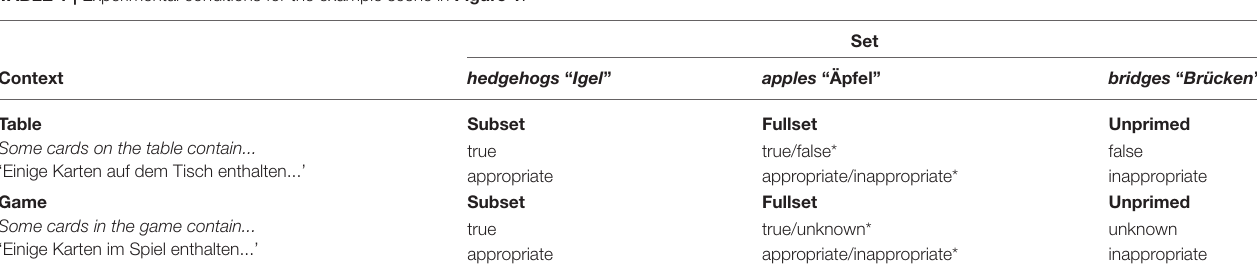
Table Some cards on the table contain... ‘Einige Karten auf dem Tisch enthalten...’ Game Some cards in the game